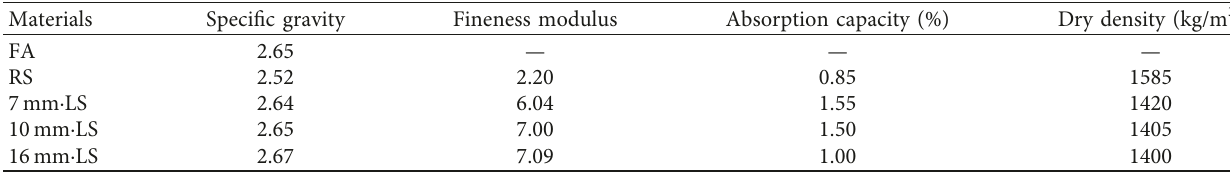
Table 2: Material properties of the AAHFAC